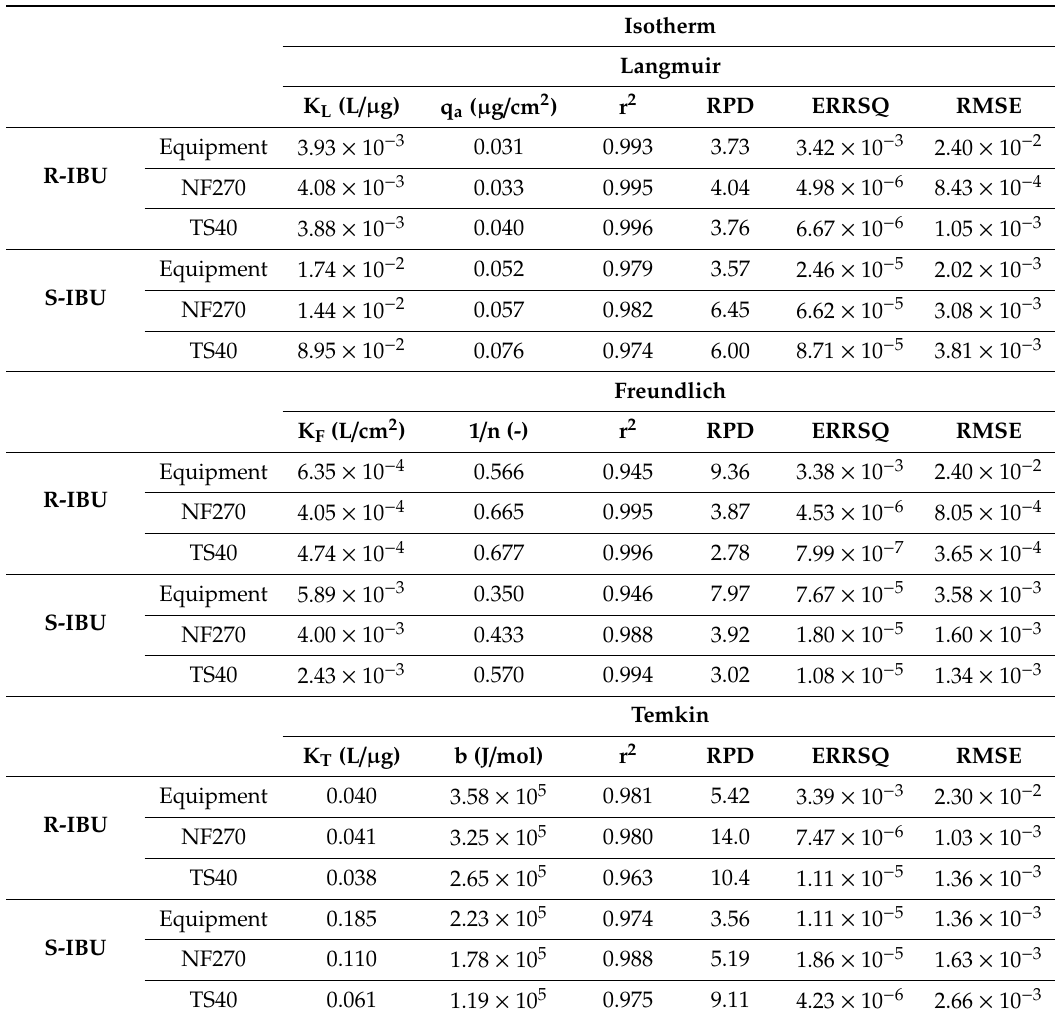
Table 3. R- and S-IBU Langmuir, Freundlich, and Temkin isotherm parameters derived from